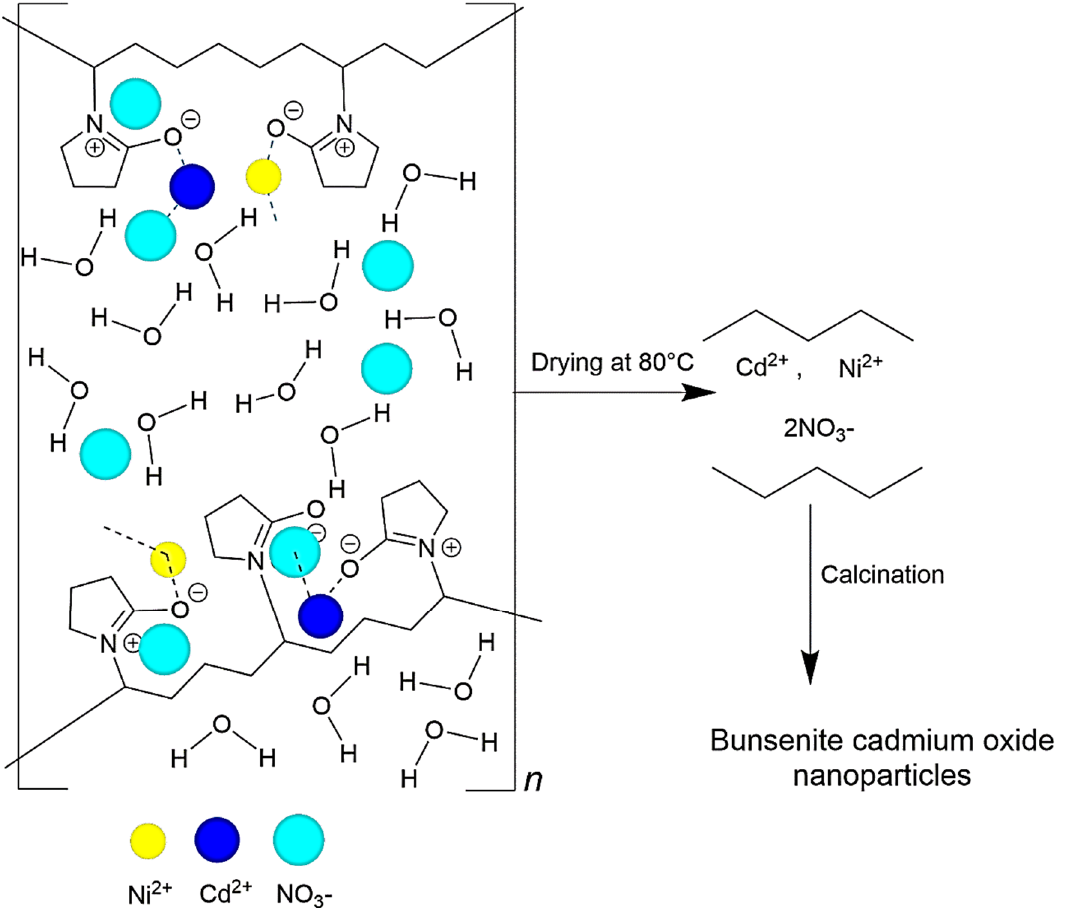
Appl. Sci. 2023 , 13 , x FOR PEER REVIEW Figure 1. Proposeddiagramgraphicoftheformationofbunsenitecadmiumoxidenanoparticles(NPs)[33]. Figure 1 . Proposed diagram graphic of the formation of bunsenite cadmium oxide nanoparticles (NPs) [33].